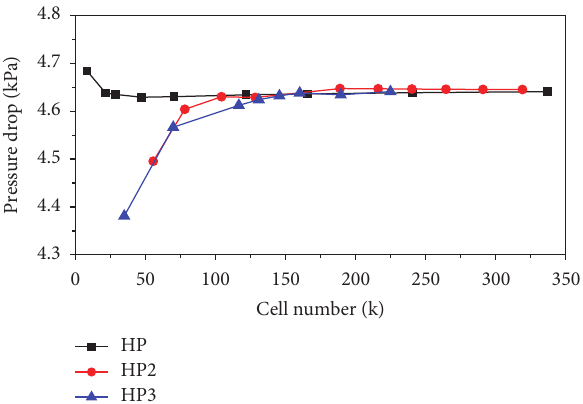
Figure 6: Analysis on hexahedral meshes.